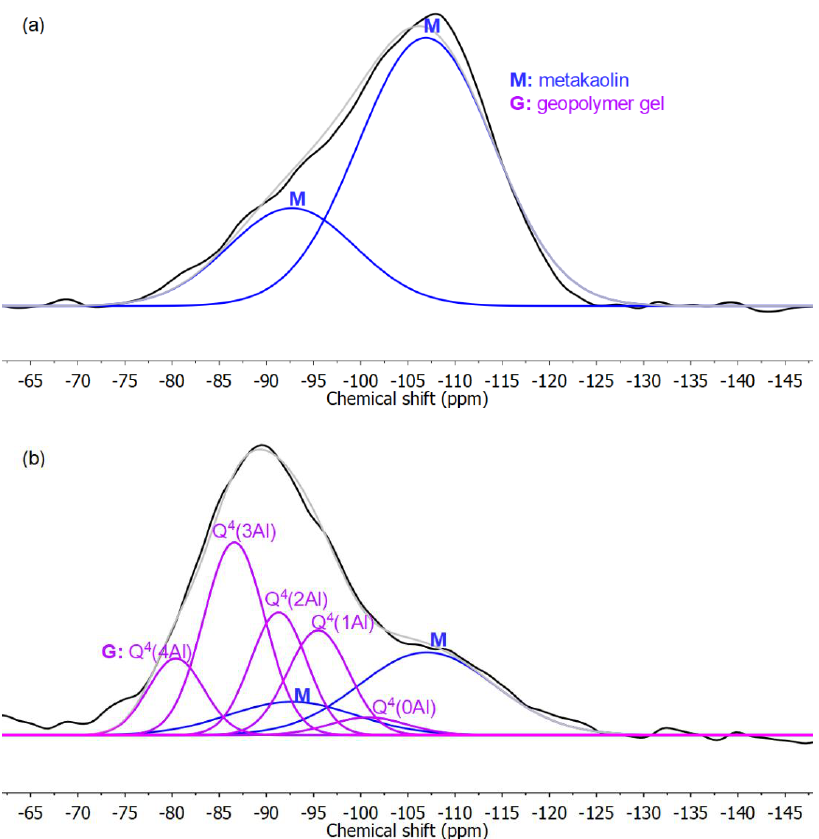
Figure 2. Deconvolution of the 29 Si NMR spectra of ( a ) HCl residue and ( b ) specimen before chemical extractions for Mixture 4 with Si/Al of 1.5. The sum of deconvoluted peaks (silver) is close to the experimental spectrum (black).